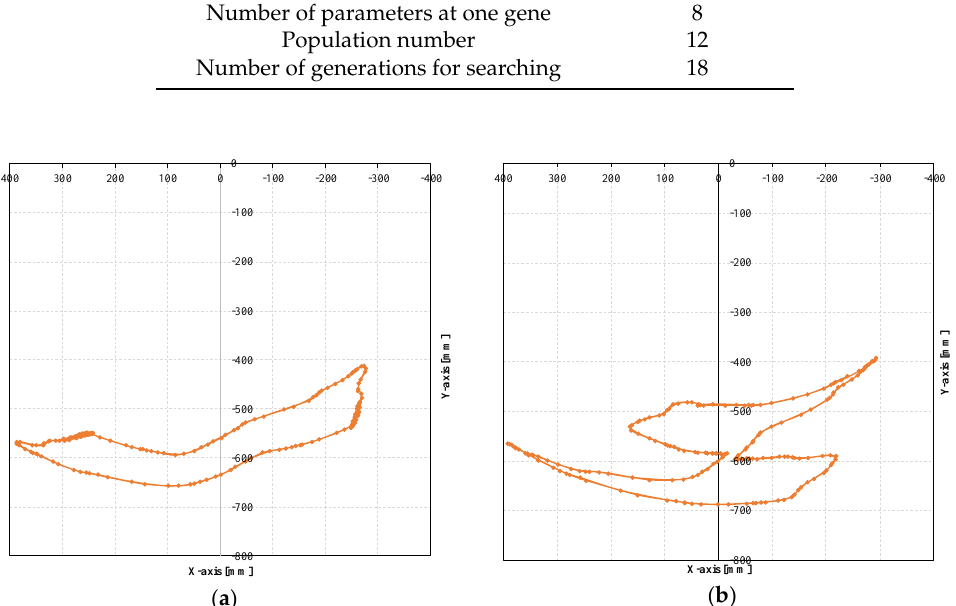
Figure 8. Trajectory of leg tip using evaluation function 1 without load (( a ) first generation, ( b ) 18th generation).